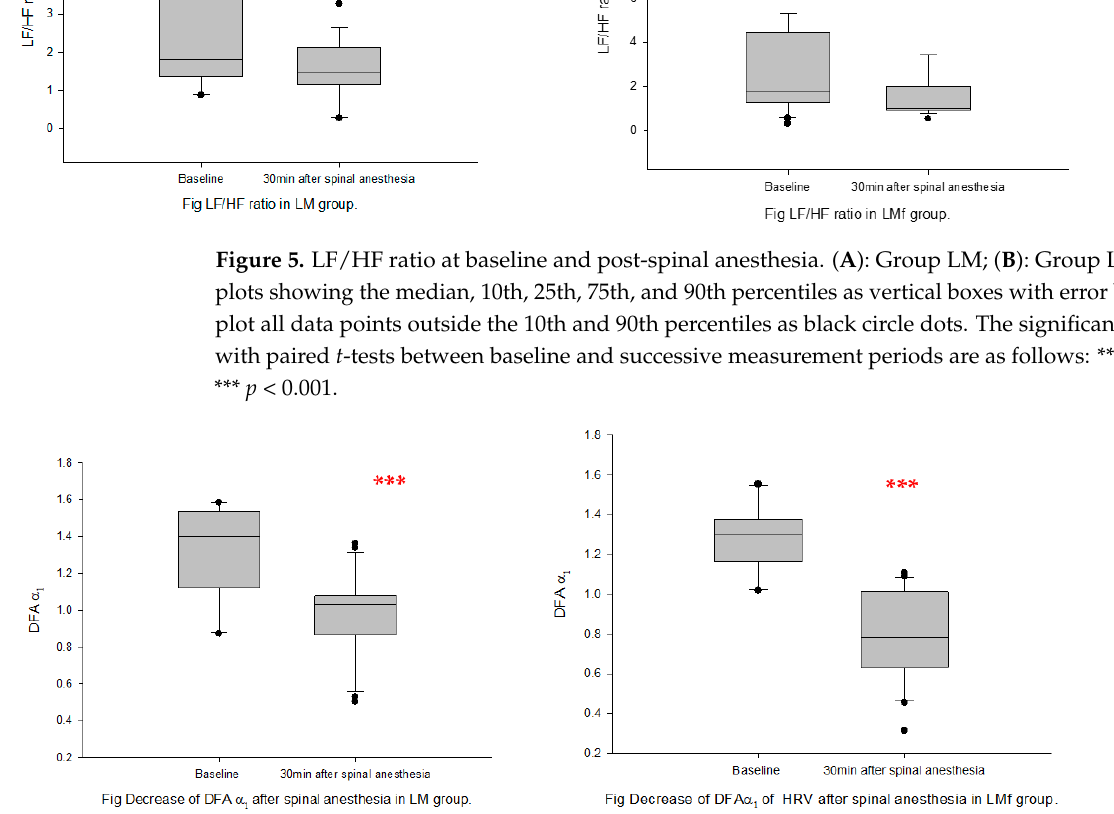
Figure 6. DFAα1 at baseline and post-spinal anesthesia. ( A ): Group LM; ( B ): Group LMf; Box plots showing the median, 10th, 25th, 75th, and 90th percentiles as vertical boxes with error bars and plot all data points outside the 10th and 90th percentiles as black circle dots. The significance levels with paired t -tests between baseline and successive measurement periods are as follows: *** p < 0.001.